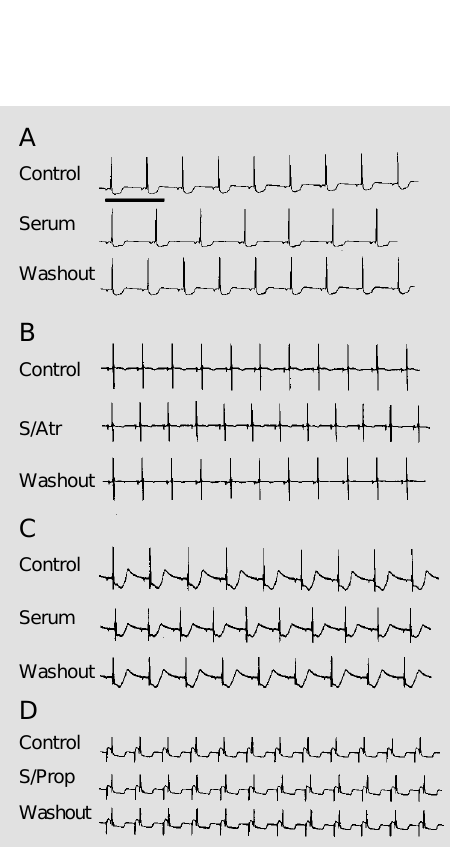
Figure 2 - Effect of patient se- rum on isolated rabbit hearts. ECG recordings for each pair were obtained from the same heart in this and subsequent fig- ures. The upper traces in each pair (control) represent ECG re- corded during Tyrode perfusion. Lower traces (serum) were ob- tained in the presence of serum diluted 1:100 (v/v) in Tyrode so- lution. Sera from chronic chagas- ic patients can induce tachycar- dia (A) or bradycardia (B). Serum from a normal patient had no ef- fect on cardiac electrogenesis